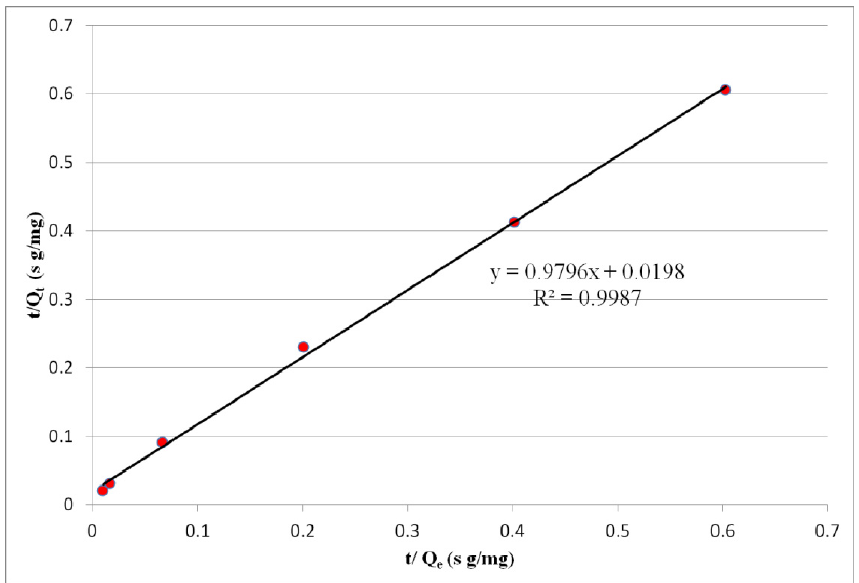
Figure 8. Curve fitting by pseudo second order reaction model on